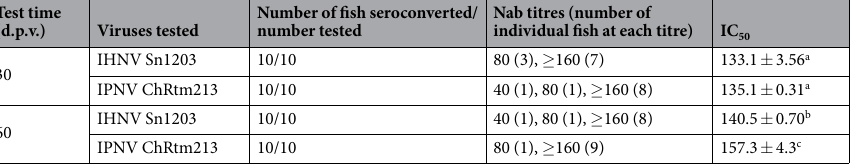
Table 1. Neutralizing antibodies (NAb) induced by pCh-IHN/IPN in rainbow trout. Differences were analysed, and different letters indicate significant differences (P <